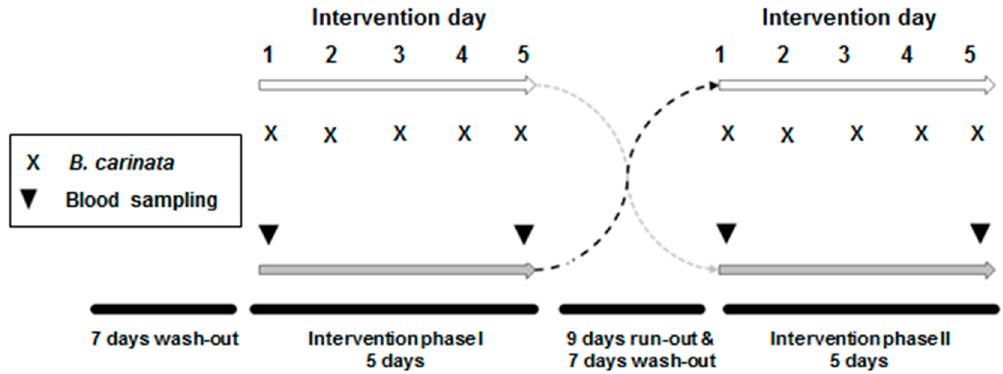
Figure 1. Design of the randomized crossover intervention trial.